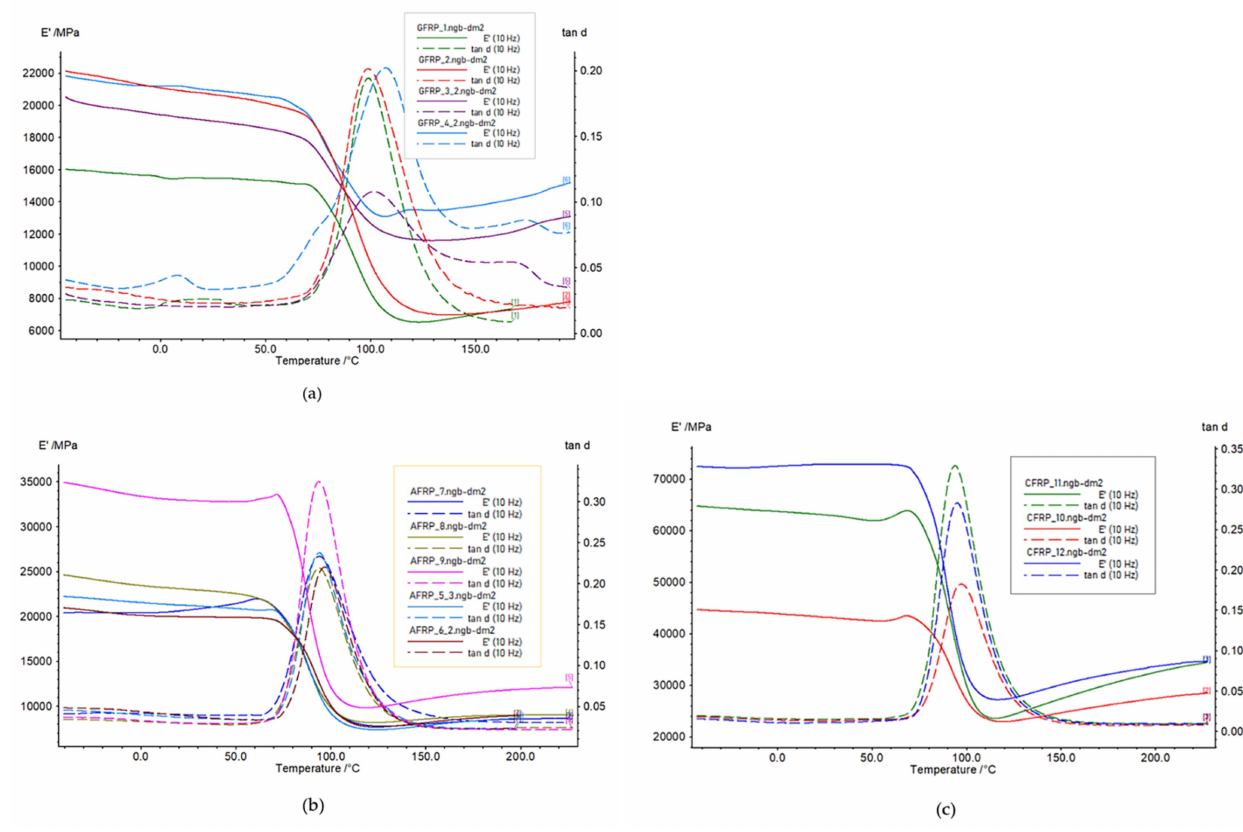
Figure 7. DMTA results of: ( a ) GFRP, ( b ) AFRP, and ( c ) CFRP. The samples were subjected to a frequency load of 10